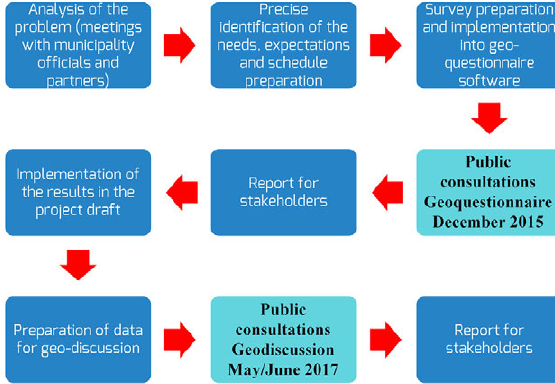
Fig. 13. Structured process of decision-making in urban planning (by E. Bąkowska et al.).